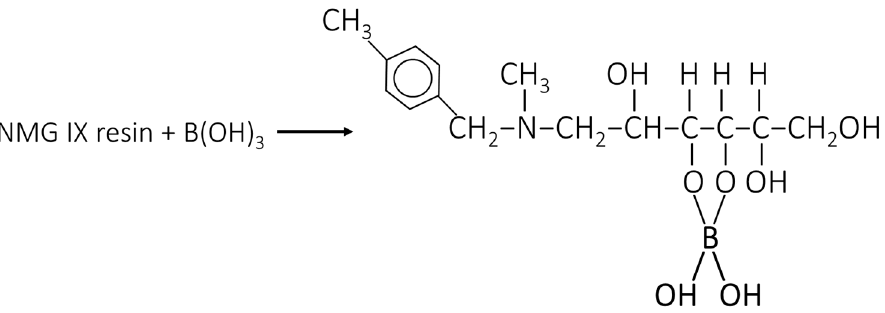
Figure A1. Boron adsorption mechanism of NMG IX resins [12].